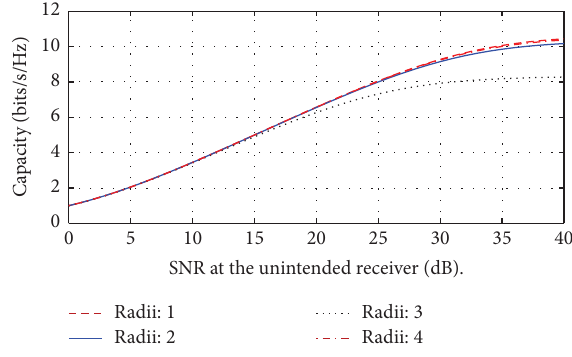
Figure 22: Capacity comparison: unintended receiver at ( − 135 degrees azimuth, 35 degrees elevation). Te radius values are wavelength normalized.